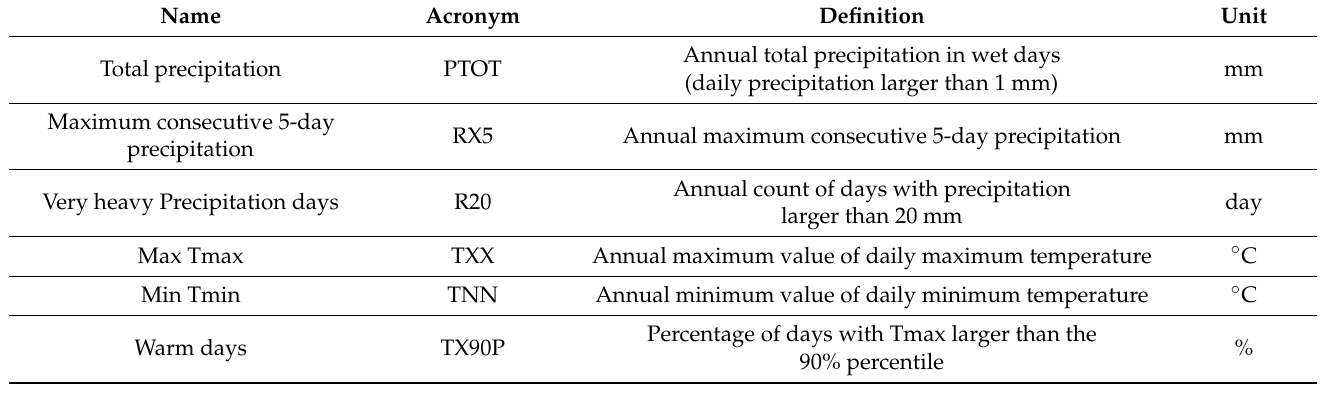
Table 2. Defintions of extreme precipitation and temperature